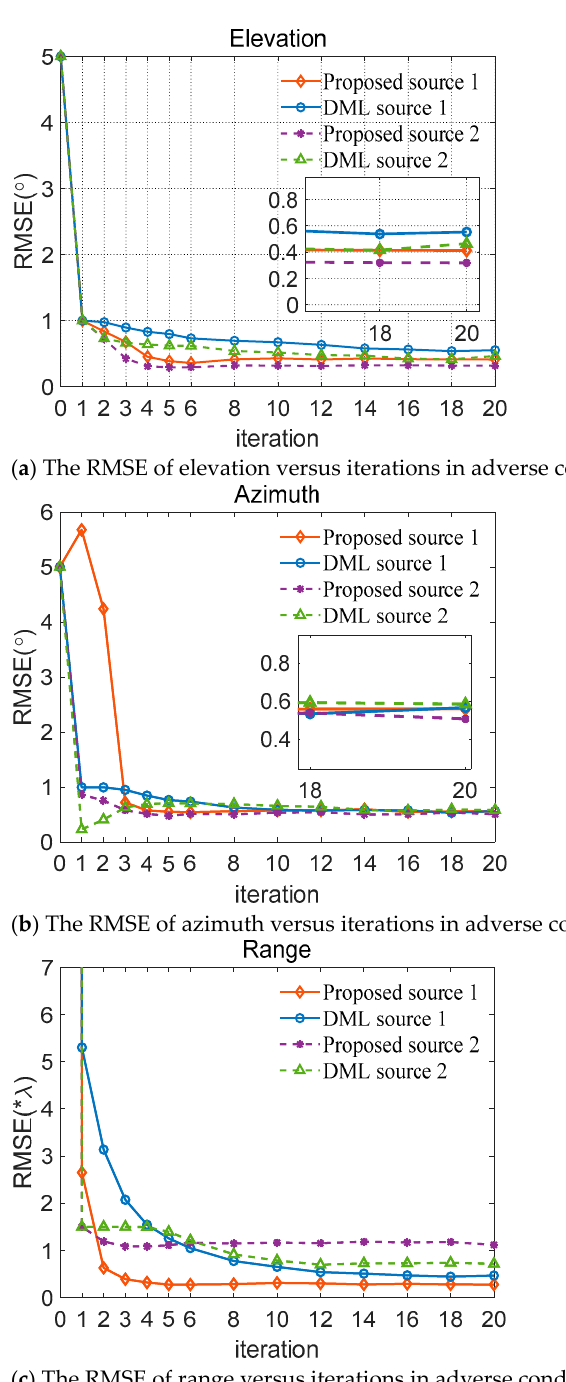
Figure 5. Convergence comparison of the two algorithms. CASE